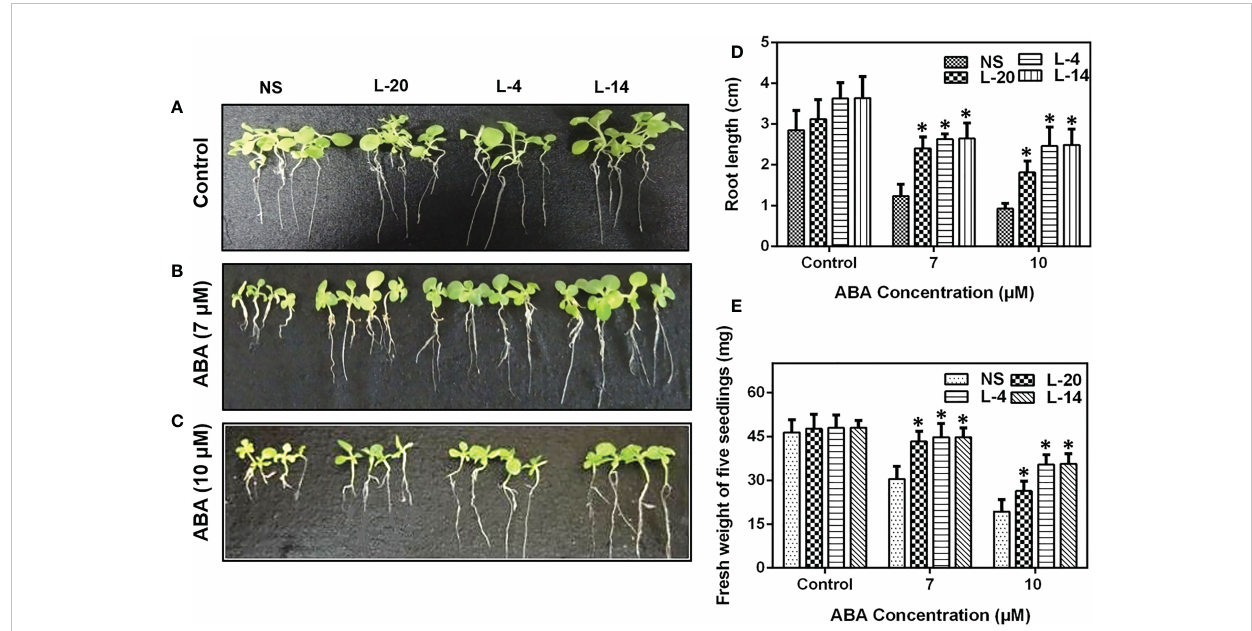
FIGURE 4 Analysis of enhanced ABA insensitivity in transgenic lines of VaDJI ; (A) Under control condition, (B) 7 µM ABA, (C) 10 µM ABA. Photographs of NS and transgenic lines were taken after giving exogenous ABA stress for 12 days of growth. The difference observed in the seedlings (D) root length, (E) fresh weight in the presence of 7 µM ABA and 10 µM ABA. Data were represented as mean ± SE. Statistical signi fi cance was tested using one-way analysis of variance (ANOVA) and *(single asterisk) indicates p ≤